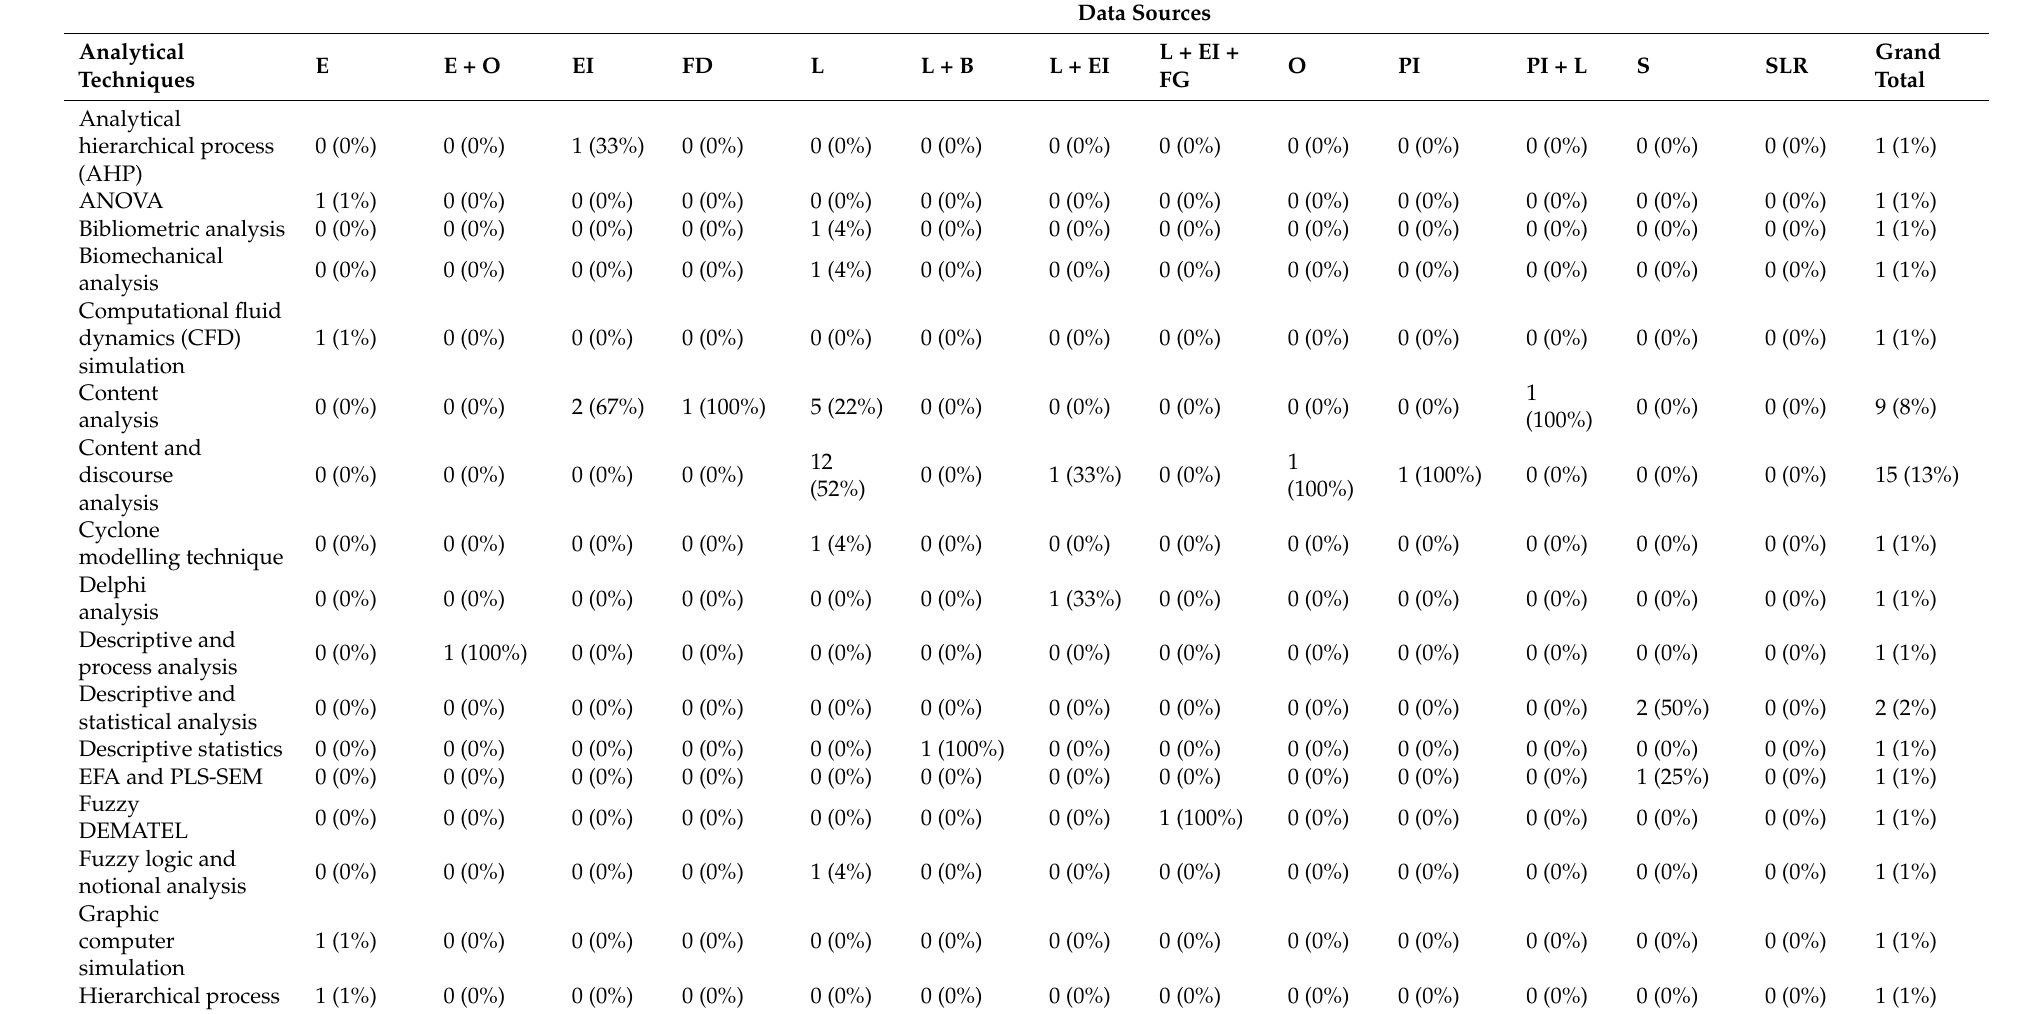
Table 4. Crosstabulation between data sources and analytical techniques used in the construction robotics